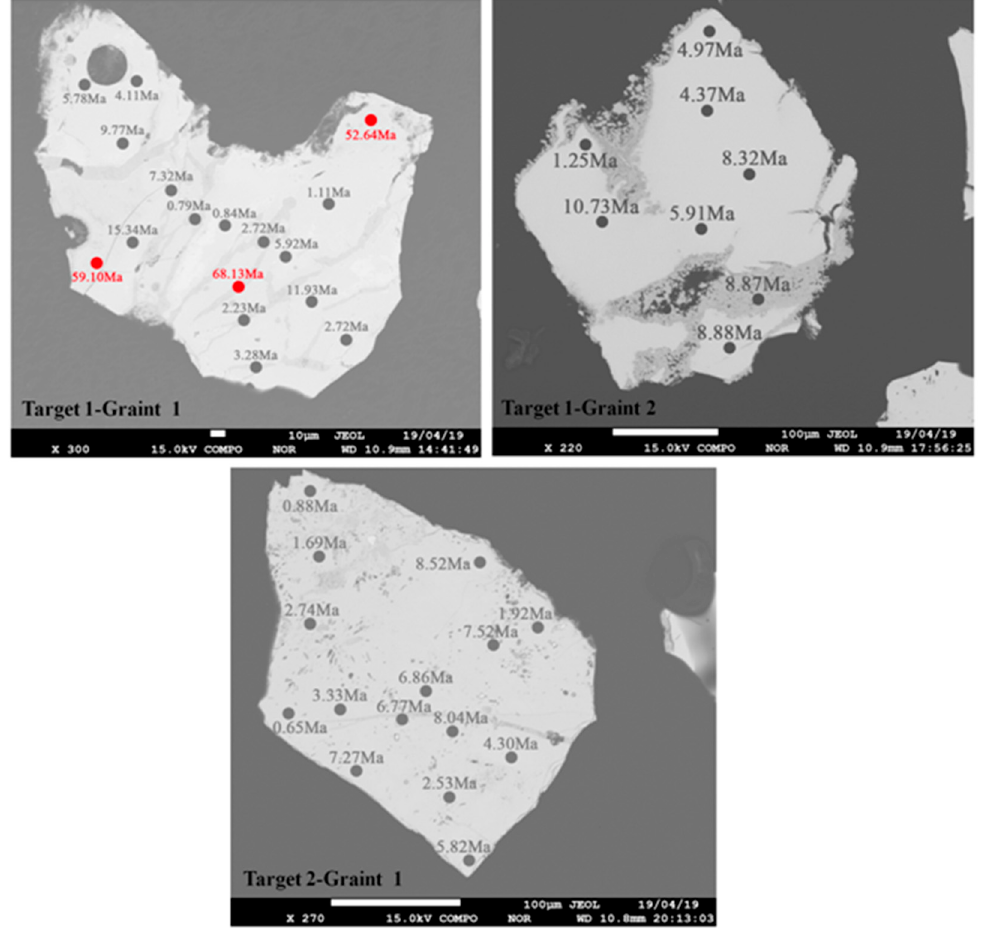
Figure 7. Calculated chemical ages of uraninite and coffinite from the MHK uranium deposit. The red circles were three extremely high values.